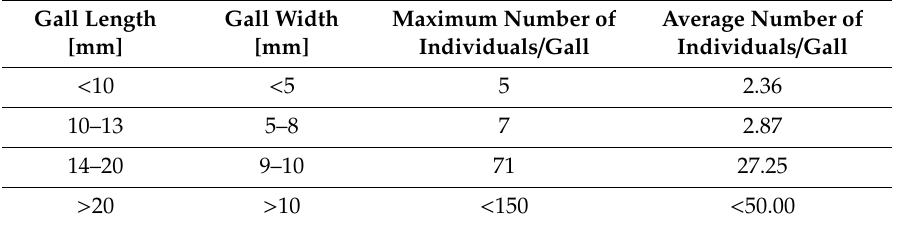
Table 1. Number of Pemphigus spyrothecae depending on gall size. Gall Length